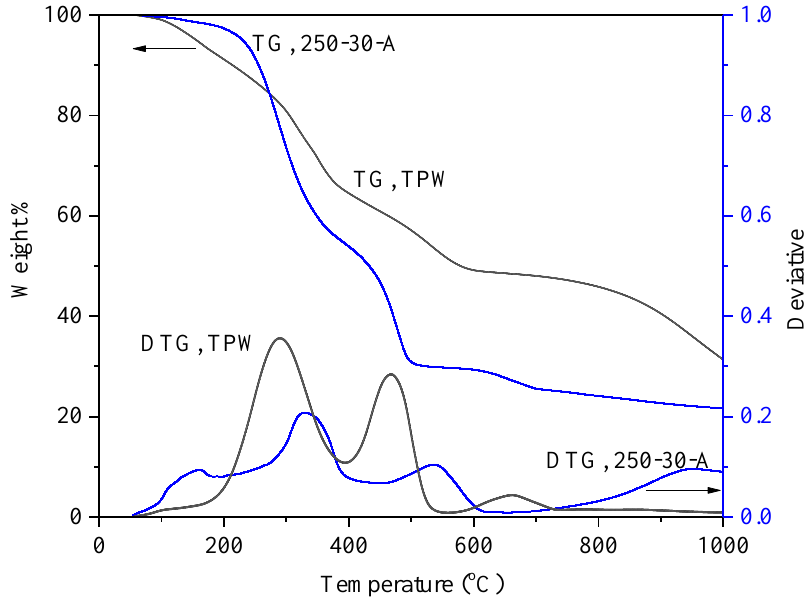
Figure 7. Thermal gravimetric analysis (TGA) and weight loss derivative curves (DTG) profiles of the bio-crude oils and TPW.